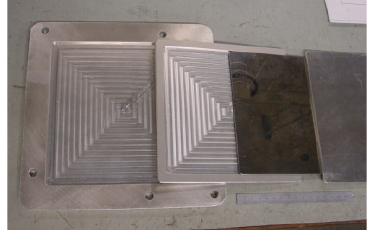
Figure 3. Milled base plate during the manufacturing process. From left to right: base plate with hole for the spheres; artefact base with steel base next to it; 2D base